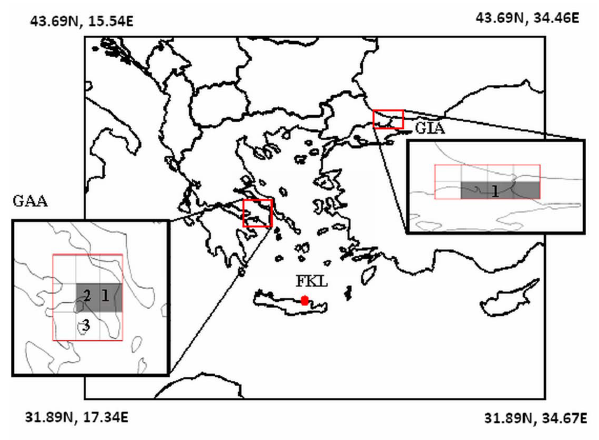
Fig. 1. Model domain, in windows the red frames indicate the Athens (GAA) and Istanbul (GIA) extended areas. The urban areas are shown in grey. In GAA, grid boxes 1, 2 and 3 show the loca- tions of GAA1, GAA2 and GAA3 groups of stations, respectively. In GIA, all stations are located in grid box